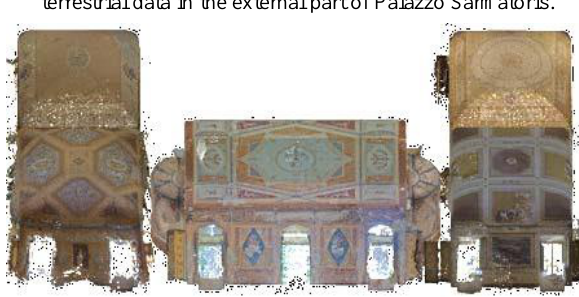
Figure 5. The Achieved point cloud obtained using UA Vand terrestrial data in the external part of Palazzo Sarmatoris.